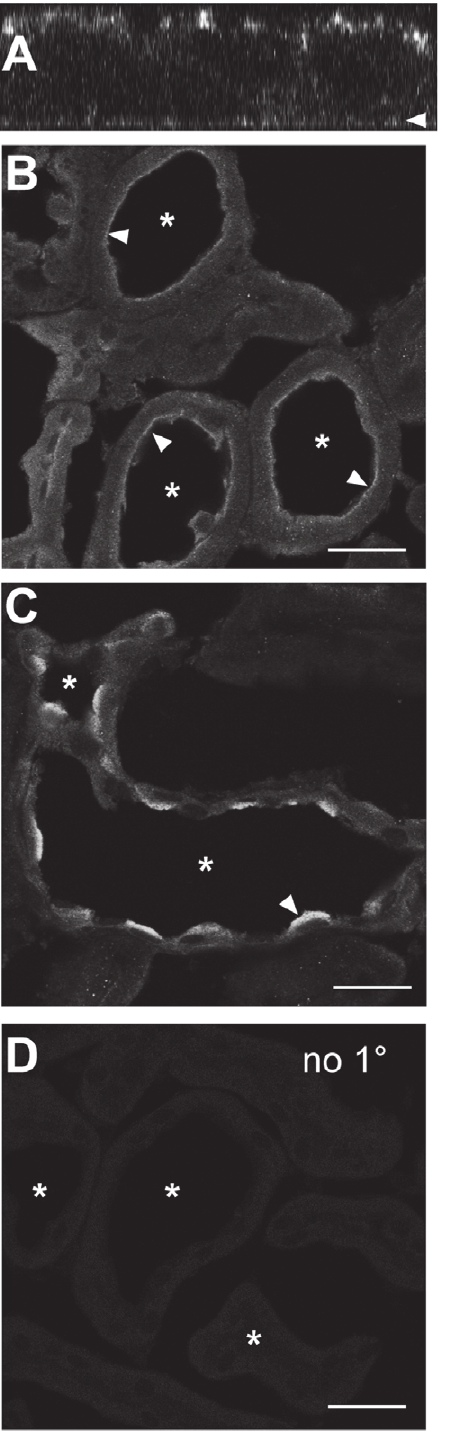
Figure 3. Endogenous PIP5KI b localizes to the apical surface of kidney cells. (A) Mouse cortical collecting duct (mCCD) cells cultured on permeable supports were fixed and processed for indirect immunofluorescence to detect endogenous PIP5KI b , which localizes predominately to the apical surface. The arrowhead denotes the position of the filter. (B-C) 4 m m rat kidney cortex slices were fixed and stained to detect PIP5KI b . Tubule lumens are indicated by asterisks. PIP5KI b is enriched at the apical (lumenal) surface, indicated by an arrowhead, of (A) kidney proximal tubule and (B) collecting duct cells. PLOS ONE |